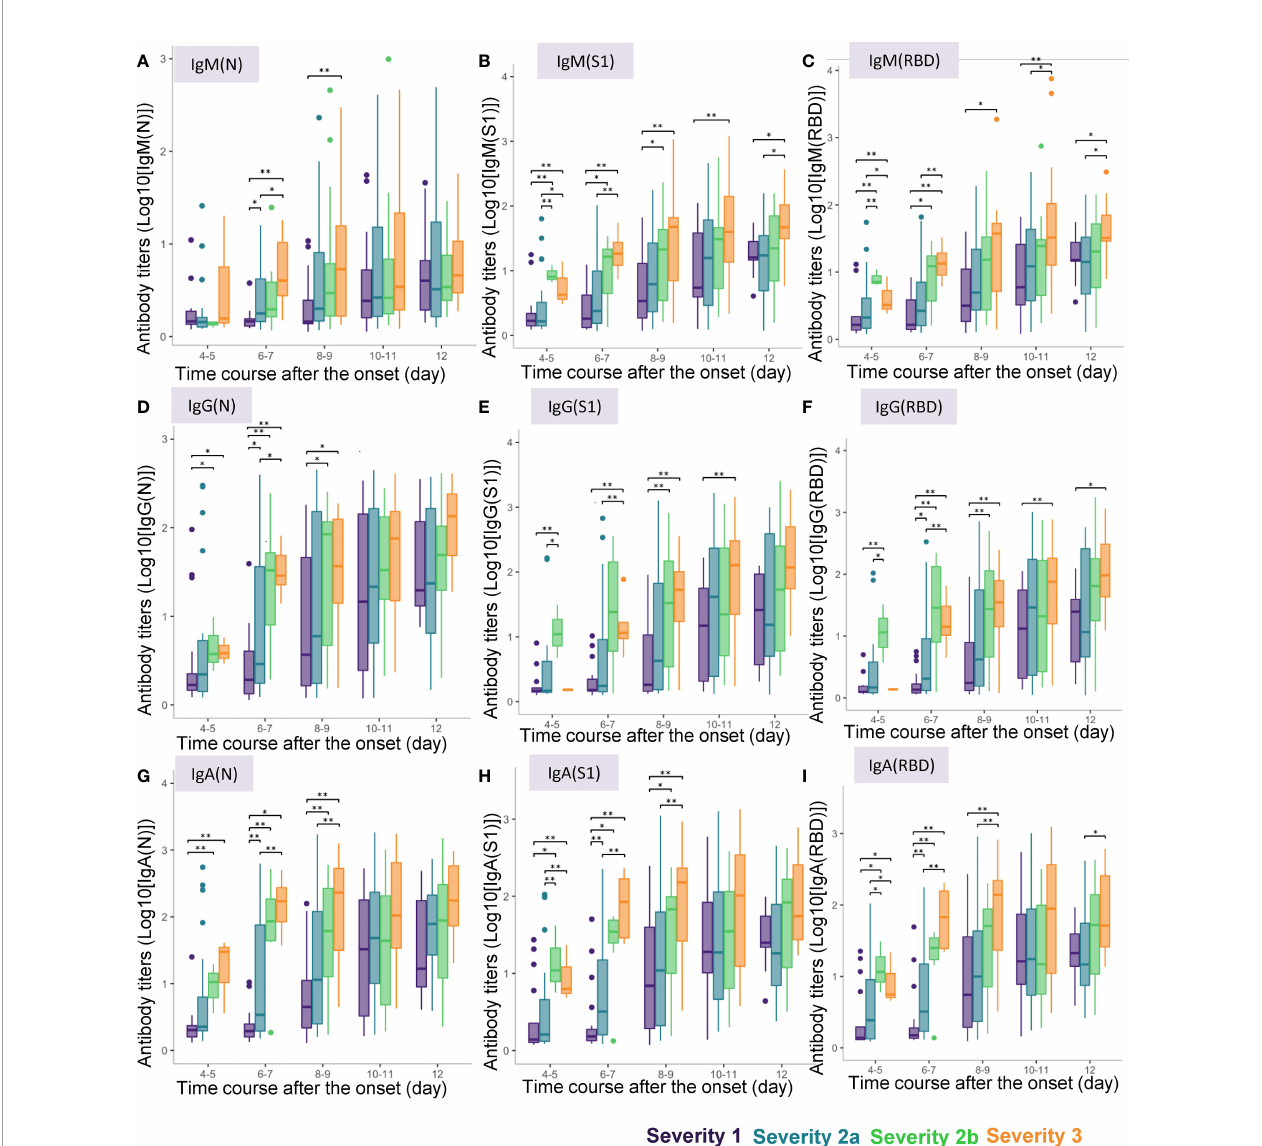
FIGURE 3 | Differences in antibody titers among COVID-19 patients classi fi ed by the disease maximum severity. We compared the titers of different types of antibodies among COVID-19 patients classi fi ed according to the disease maximum severity as described in the Material and Methods section, measured on day 4-5, day 6-7, day 8-9, day 10-11, day 12 after symptom onset. *P < 0.05, **P < 0.01. The horizontal bar represents the median, the box bar represents the lower and upper quartiles, and the fi ne bar represents the minimum and maximum. (A) IgM(N), (B) IgM(S1), (C) IgM(RBD), (D) IgG(N), (E) IgG(S1), (F) IgG(RBD), (G)